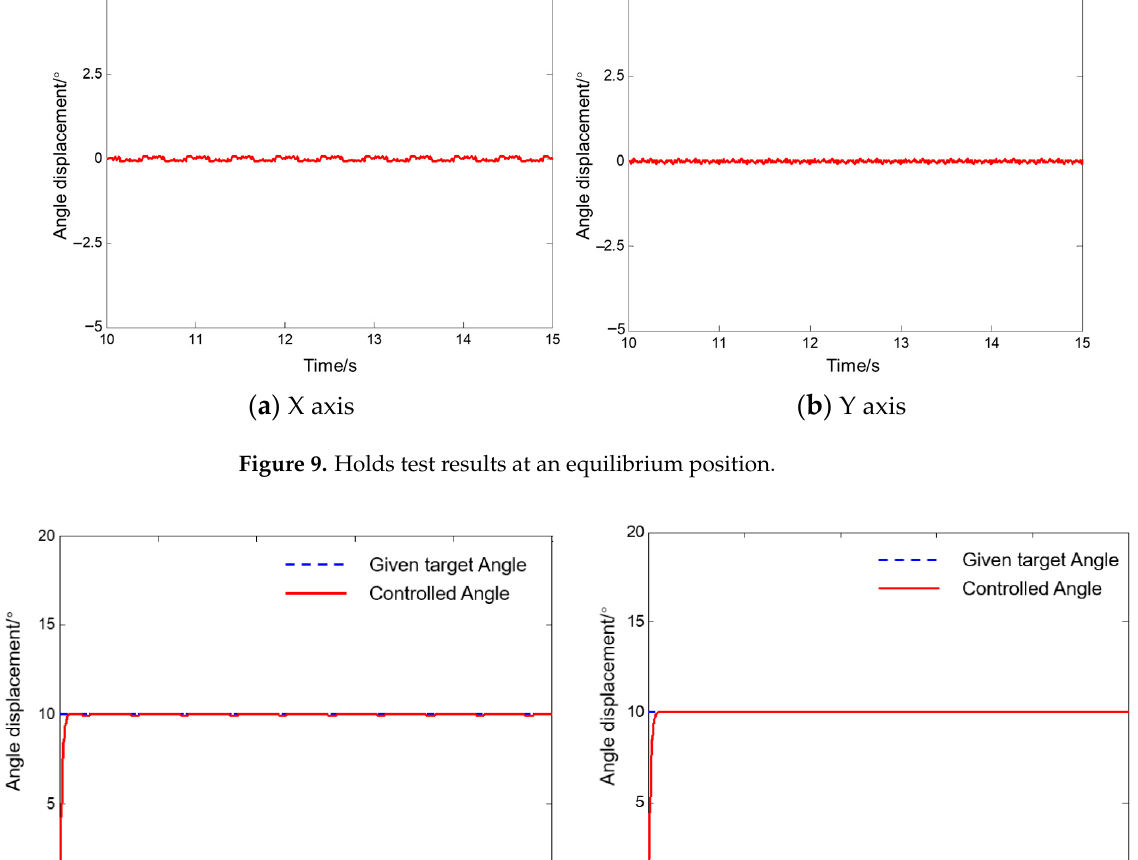
Figure 8. Maximum angle leveling state. ( a ) The maximum angle generated at the farthest end of the swing system. ( b ) The maximum angle generated at the closest end of the swing system.